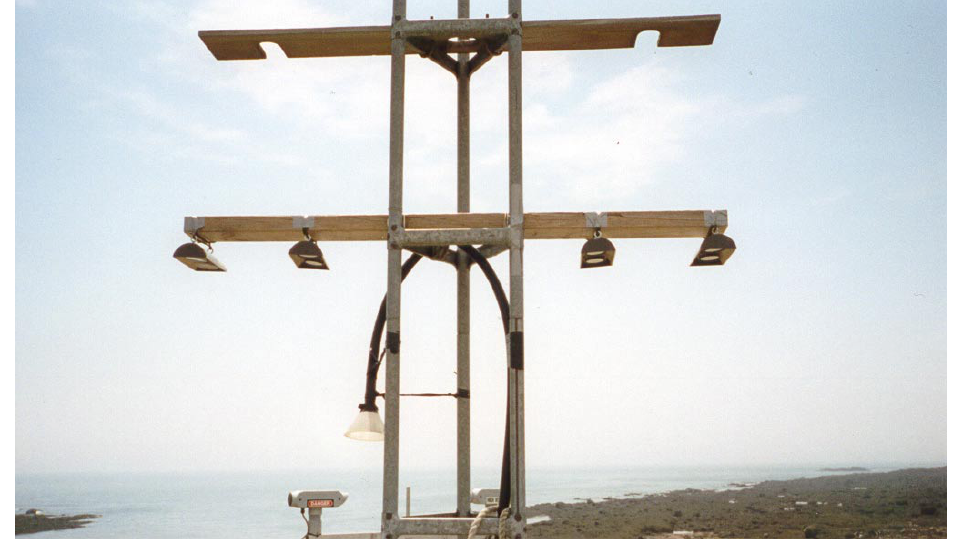
FIGURE 4. Installation of the array of CanOxy Plate passive ozone samplers colocated with a New Brunswick provincial air quality monitor (Point Lepreau). These are used to calibrate the canopy